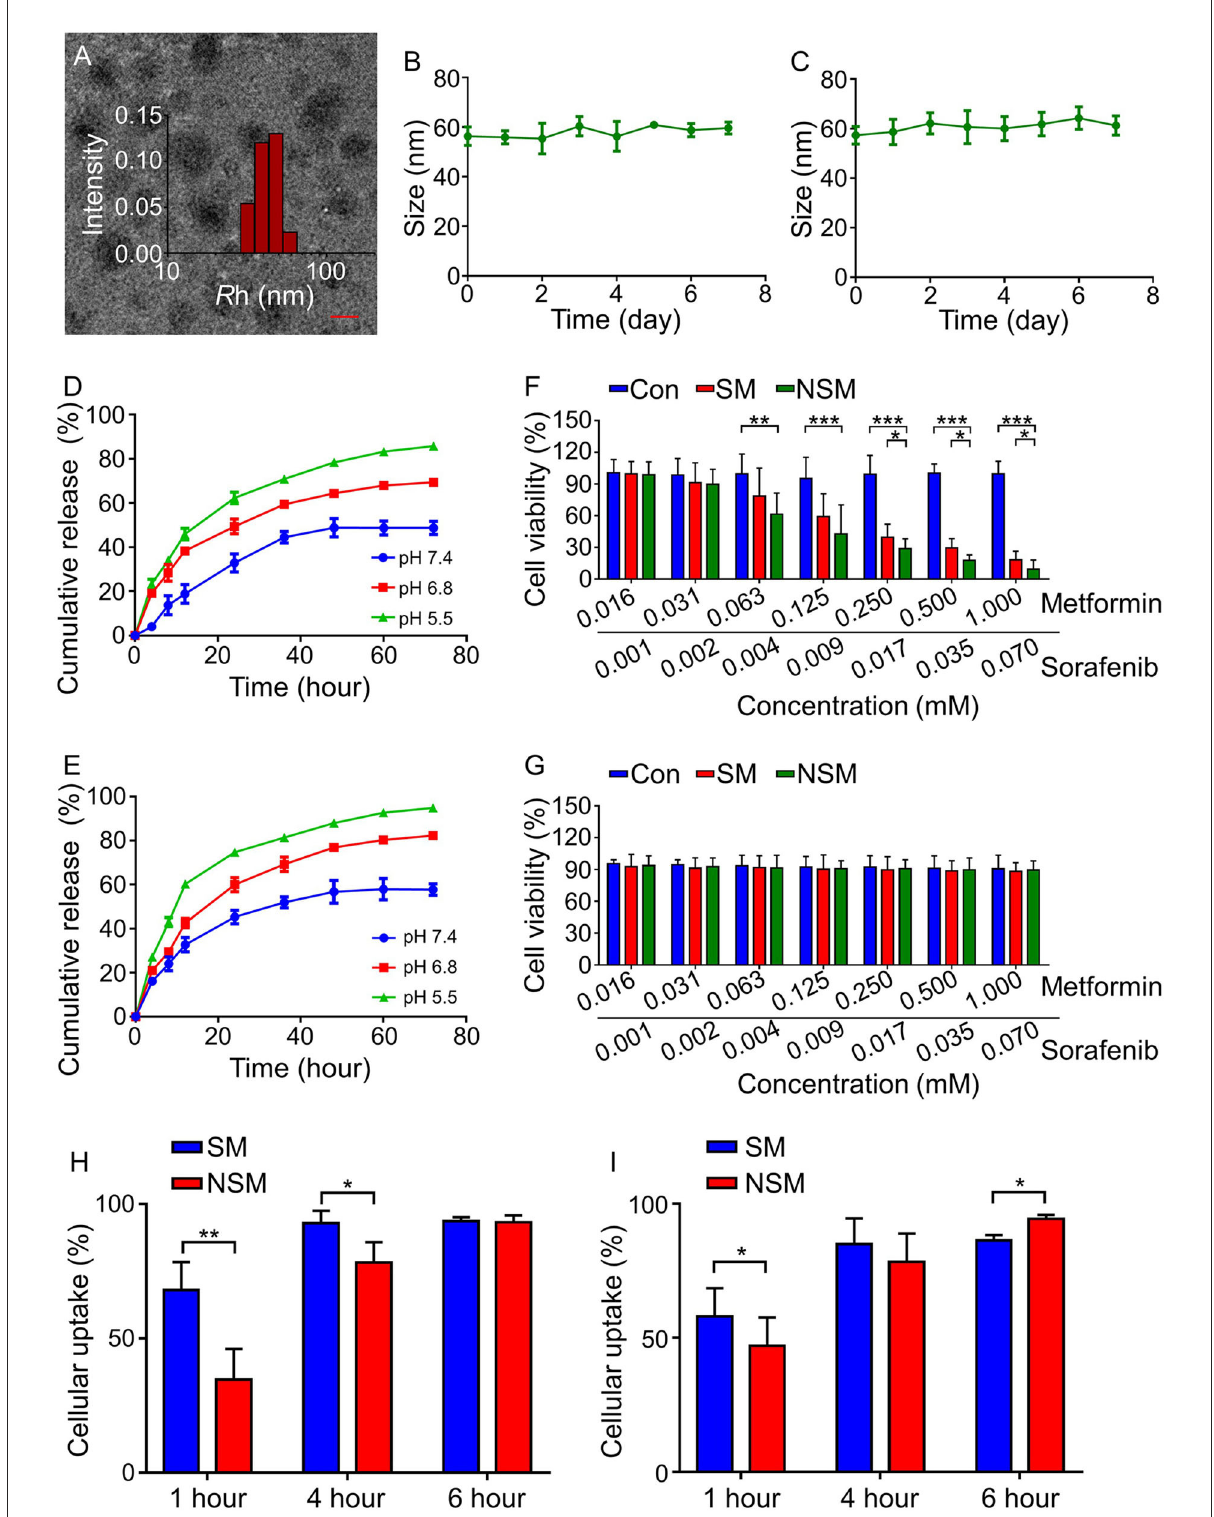
FIGURE2 Characterizations of mPEG- b -P(Glu- co -Phe) micelles. (A) TEM and DLS analyses. NSM stability in (B) PBS and (C) BSA solution. Release profiles of (D) Sor and (E) Met in PBS solution at different pH values. In vitro cytotoxicity analyses on (F) H22 cells and (G) HLL-5 cells at different Met and Sor concentrations in different groups. Cellular uptakes of (H) Sor and (I) Met of SM and NSM after incubation with H22 cells for 1, 4, and 6h. Scale bar = 50nm. *, **, *** represent P < 0.05, P < 0.01, and P < 0.001,